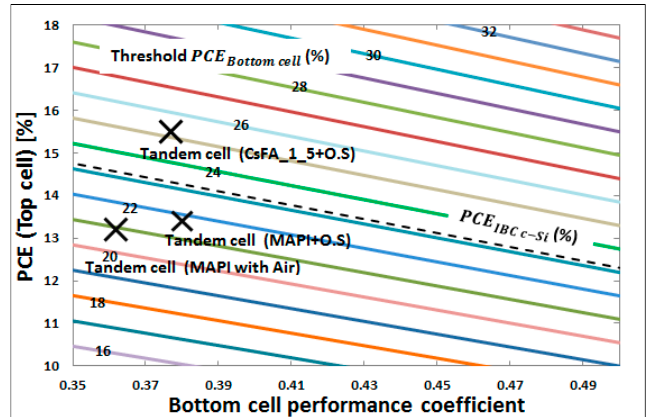
Figure 7. Performances of sub-cells are compared with four-terminal tandem device based on two type of perovskite based solar cells and the same IBC cSi solar cell. Note: O.S. in the figure stands for optimized optical spacer.